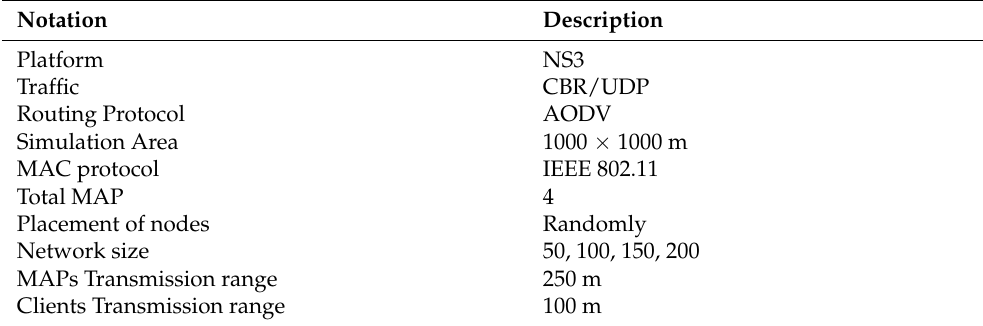
Table 2. Experimental model